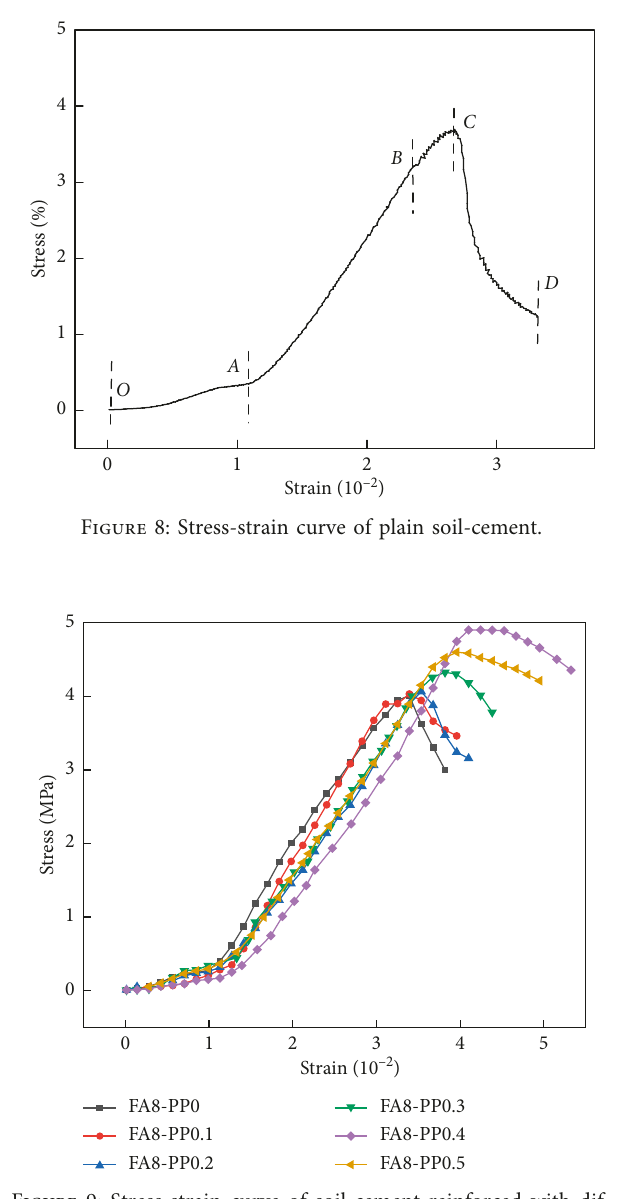
Figure 9: Stress-strain curve of soil-cement reinforced with dif- ferent polypropylene fiber and 8% fly ash contents.